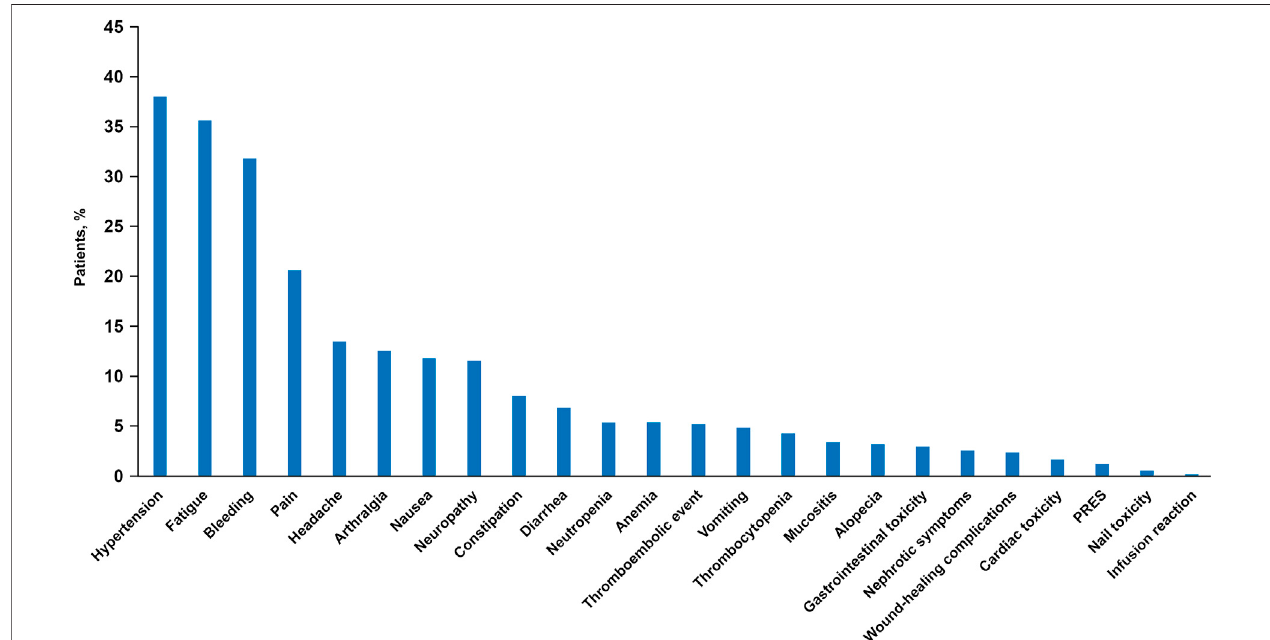
FIGURE2| Percentage(in descending order) ofpatients experiencingadverse events(allgrades).Verbatimterms recordedundertargetadverseeventcategories wereasfollows: thromboembolicevents: phlebitis ( n (cid:1) 8), pulmonary embolism( n (cid:1) 6), cerebrovascular accident ( n (cid:1) 1), other ( n (cid:1) 12). Gastrointestinal toxicity: subileus ( n (cid:1) 2), gastrointestinal perforation, constipation, abdominal distention, upper abdominal pain, dyspepsia, fi stula, enterocutaneous fi stula, perineal fi stula, umbilical hernia, intestinal occlusion, wound evisceration/stomal complication/ fi stula/dehiscence/urinoma, gastrointestinal disorders (each n (cid:1) 1). Cardiac toxicity: hypertension ( n (cid:1) 2), palpitations ( n (cid:1) 2), pulmonary artery hypertension, aortic insuf fi ciency/palpitations/supraventricular extrasystole, acute coronary syndrome, tachycardia, poorly de fi ned (each n (cid:1) 1). PRES, posterior reversible encephalopathy syndrome.